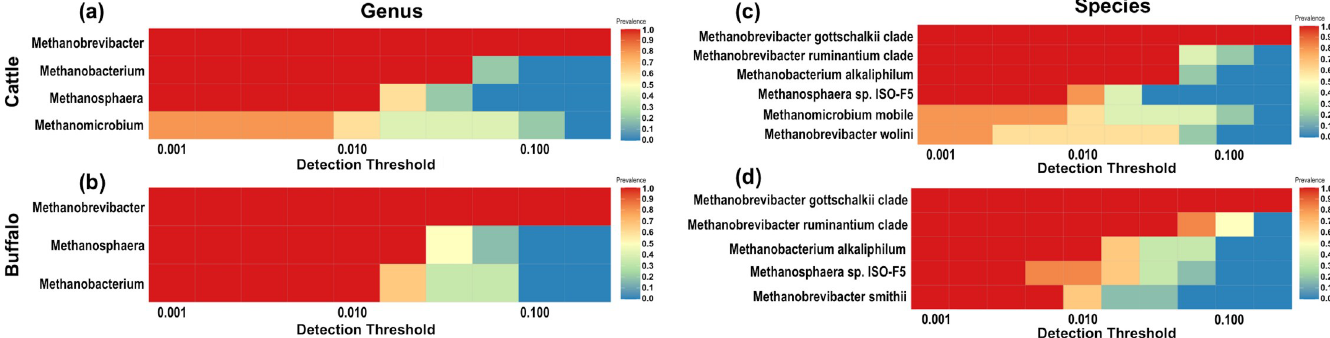
Fig 4. Ruminal archaea representing the core microbiome at 50% minimum prevalence in (a) Cattle at genus level (b) buffalo at genus level (c) cattle at species level (d) buffaloes at species level. The colour gradient indicates variability in prevalence.